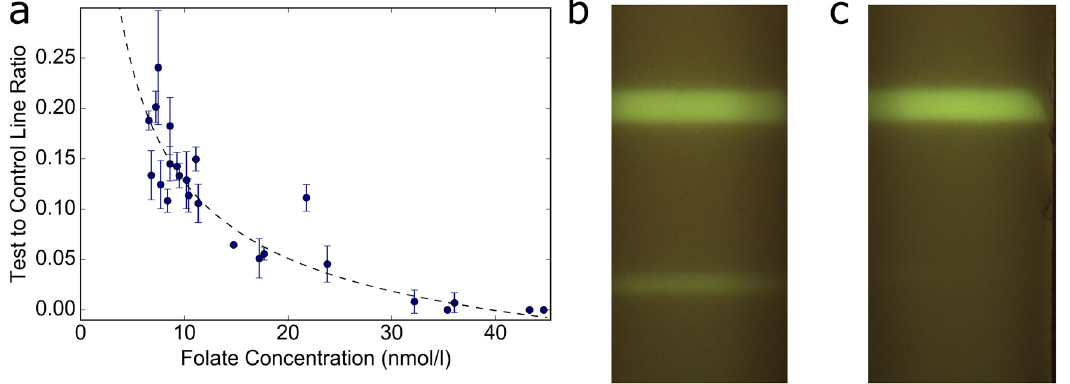
Fig 2. Human serum results. (a) Mean T/C ratio versus folate concentration for 24 human serum samples. Error bars shown are standard deviation, n = 3. Dotted line shows four-parameter logistic curve fit. (b,c) Images of fluorescent signal from test strip for low and high folate concentration serum,